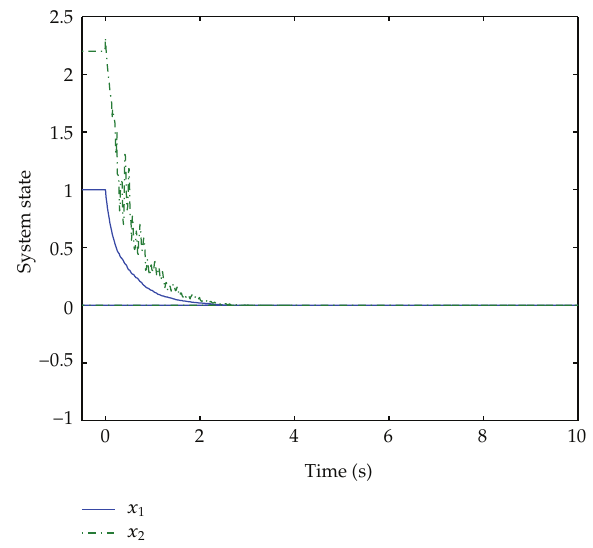
Figure 5: The state trajectories of the closed-loop system under SOF